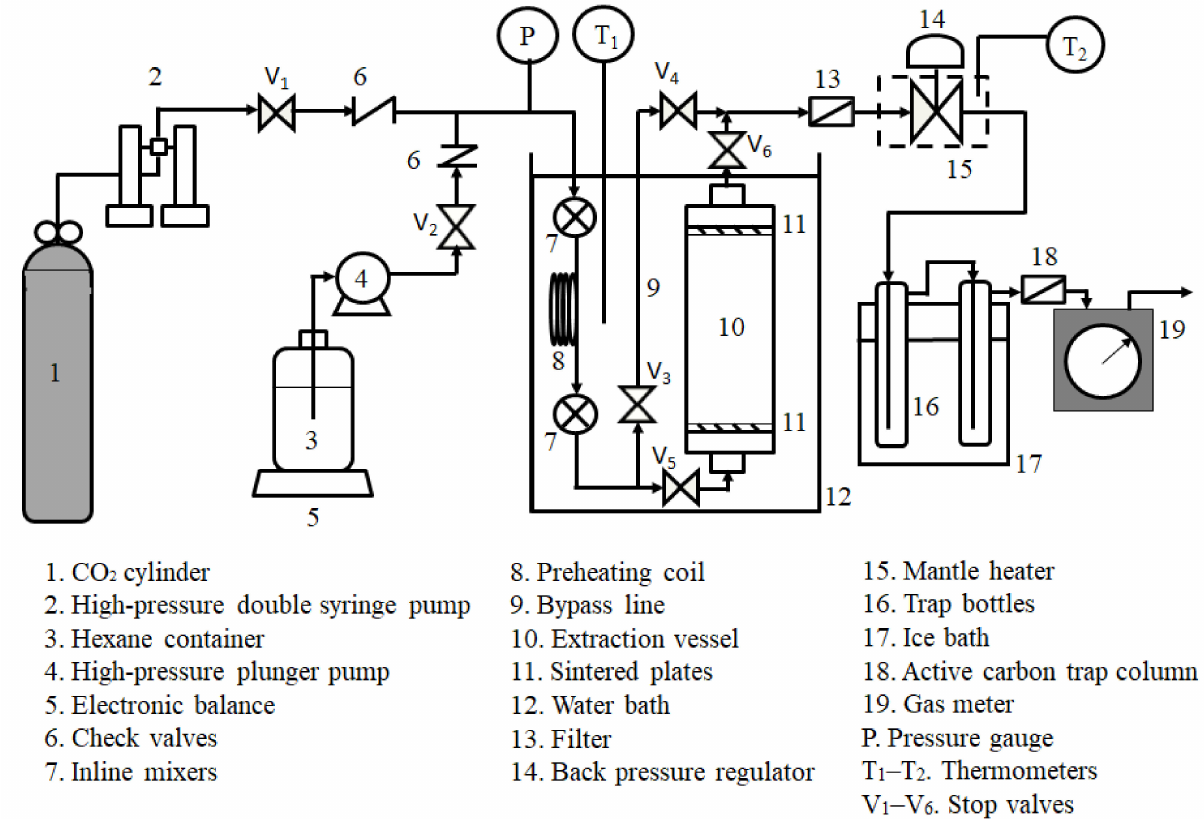
Figure 1. Semi-flow-type equipment for rice bran oil extraction with CO 2 -expanded hexane. The cylindrical extraction vessel (10) in the semi-flow-type apparatus was composed of 316 stainless steel. The inner volume was approximately 180 cm 3 , the length was 250 mm, and the inner diameter was 30 mm. The vessel was equipped with stainless steel sintered plates with a pore size ~2 µ m (11) on both sides to ensure the uniform dispersion